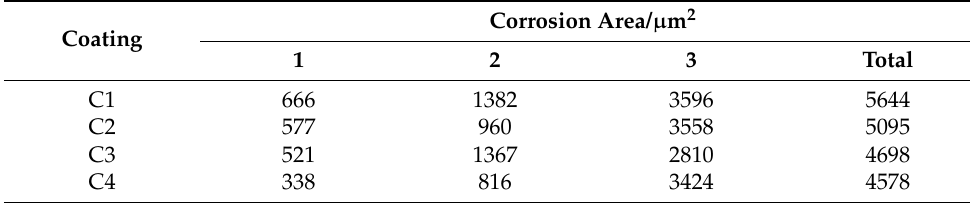
Table 5. Areas of the corresponding corrosion.